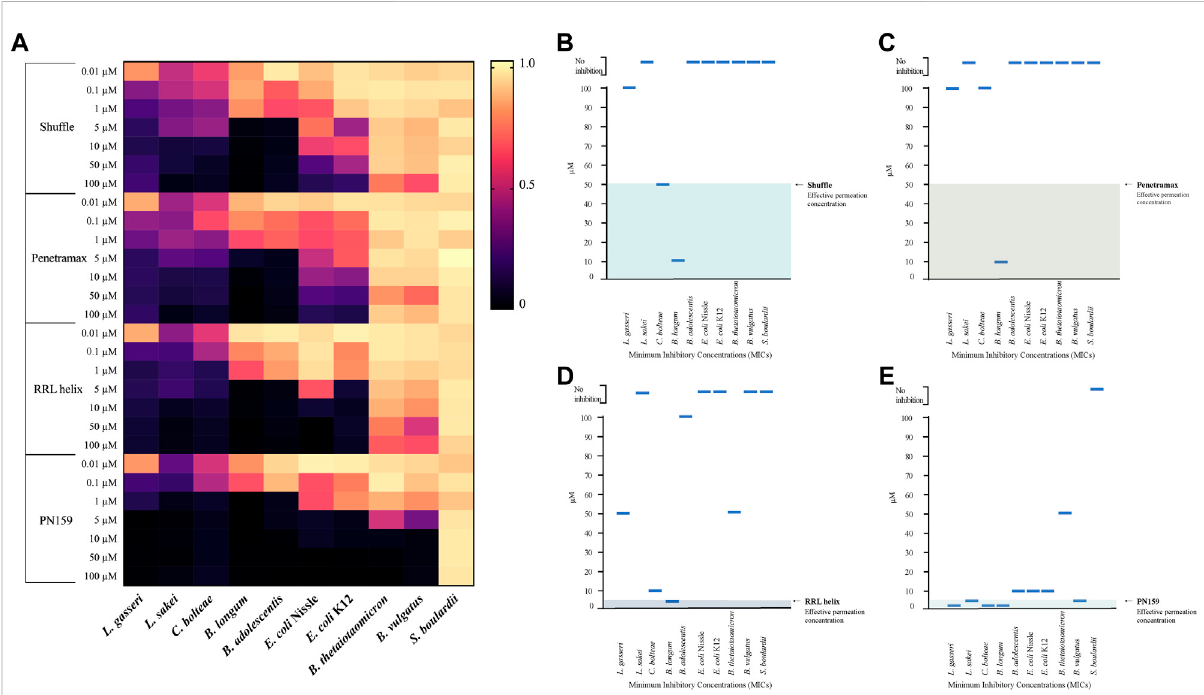
FIGURE 3 AntimicrobialeffectsofCPPsongutcommensalmicrobialstrains. (A) HeatmapshowingtheantimicrobialeffectsoftheCPPsRRLhelix,Shuf fl e, Penetramax, and PN159 in various concentrations ranging from 0.01 µM to 100 µM against different commensal gut microbial strains. The fi nal OD 600 values after 24-hour treatment with CPPs were normalized to values between 0 and 1, where 1 being full growth (no CPP treatment) and 0 being no growth (media only). (B – E) showing the minimum inhibitory concentrations (MICs) along with their effective permeation concentrations (from permeability study) for the CPPs Shuf fl e, Penetramax, RRL helix, and PN159